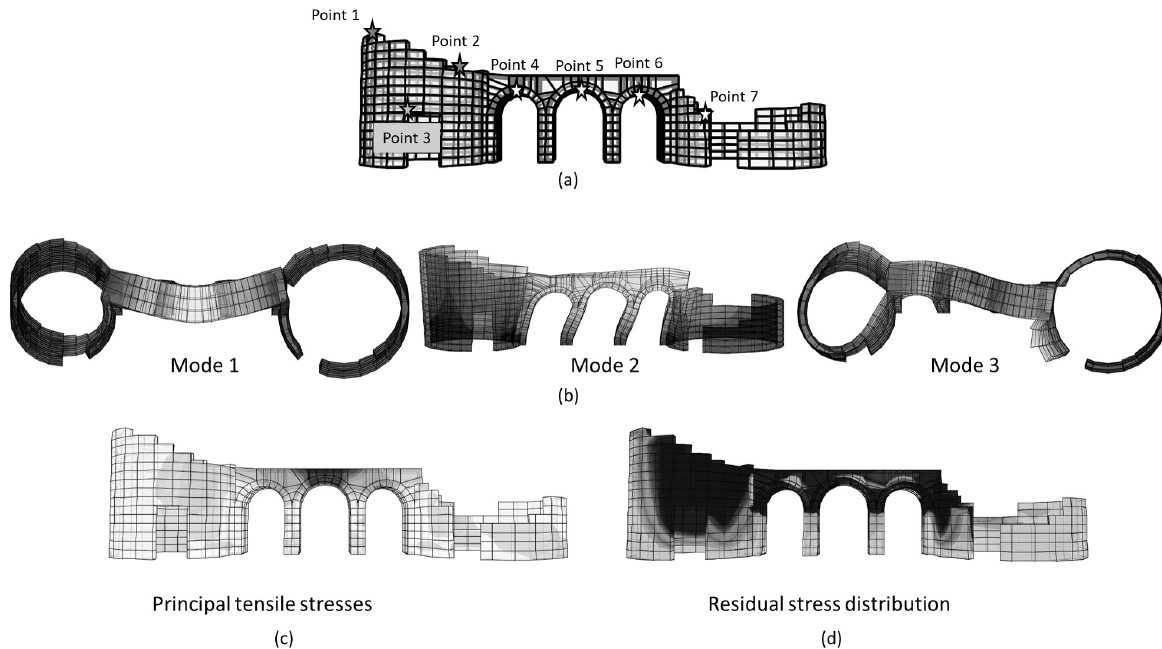
Figure 4 (a). Finite element model of the Frontinus Gate. (b) First three mode shapes of the numerical model. (c) Principal tensile stresses. (d) Residual stress